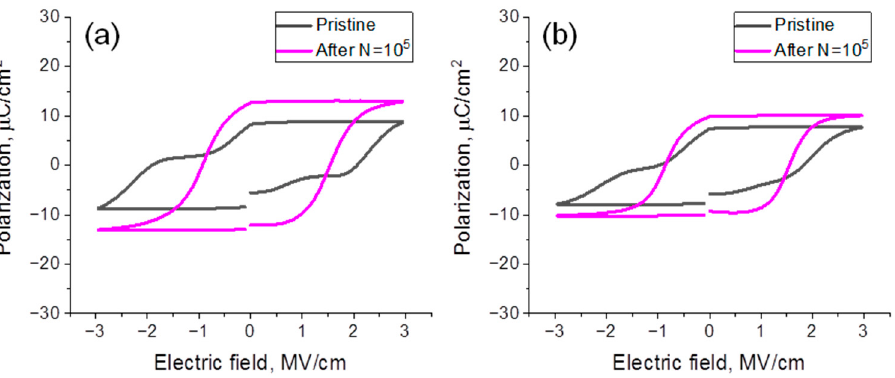
Figure 2. Polarization hysteresis loops measured from the devices with TiN ( a ) and Ru ( b ) TE in pristine and woken-up